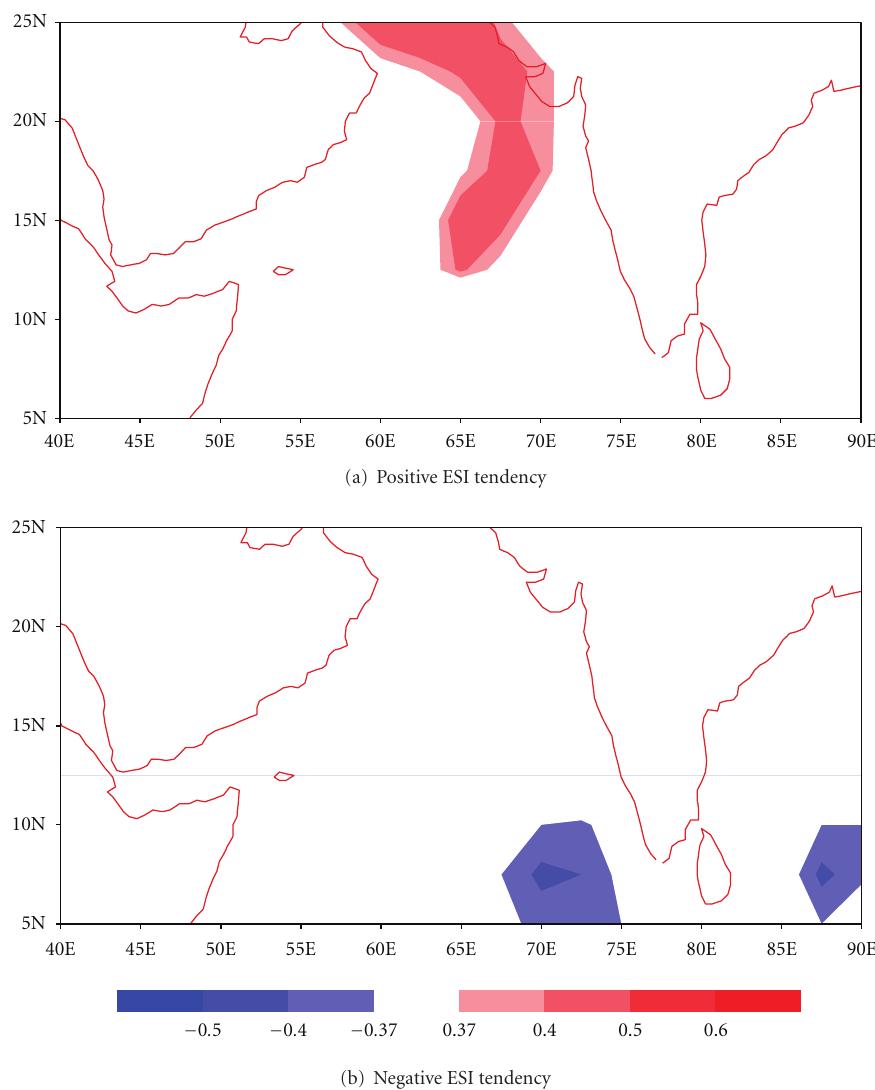
Figure 2: The correlation coe ffi cients between ISMR and Winter temperature anomaly over Arabian sea and Bay of Bengal (5 ◦ –25 ◦ N, 40 ◦ – 90 ◦ E) during (a) positive (29 years) and (b) negative (28 years) ESI tendency.